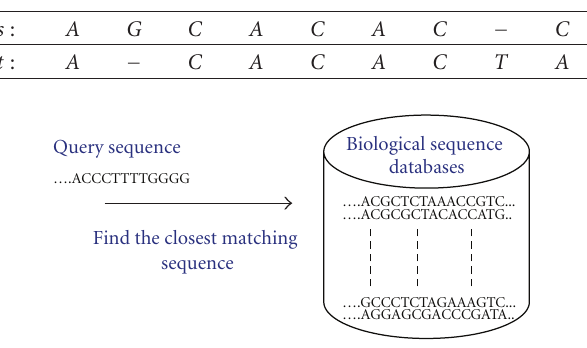
Table 1: Denotations of the alignment between sequences s and t .